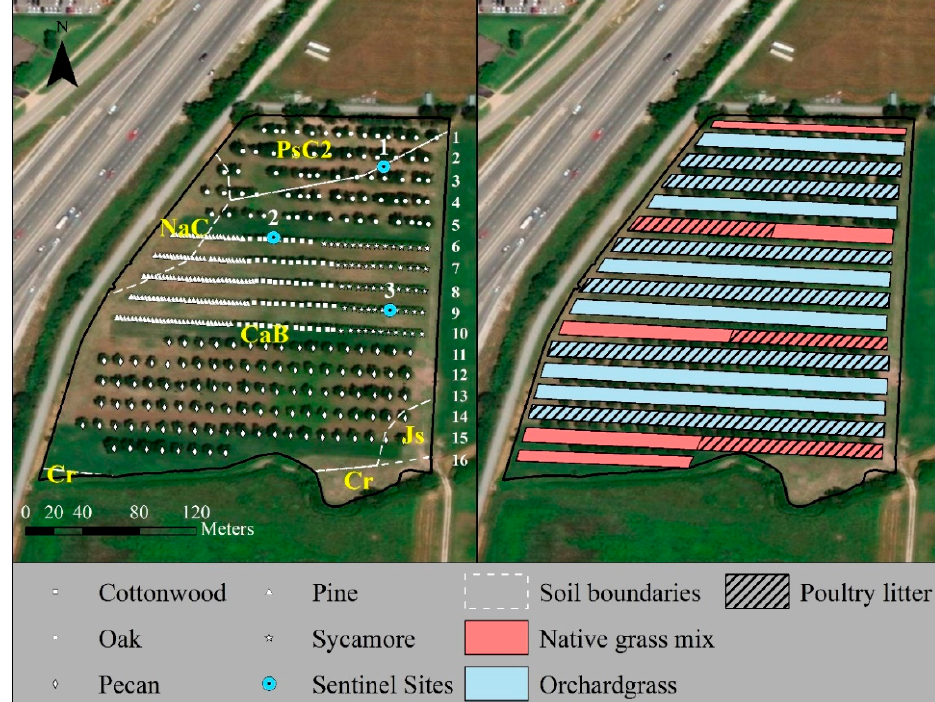
Figure 1. Agroforestry site in Fayetteville, AR is organized into 16 rows, where Row 1 starts at the most-northern row. Rows 1–5 consist of the northern red oak; the western, central, and eastern portion of Rows 6–10 consist of the pitch/loblolly pine, cottonwood, and American Sycamore; and Rows 11–16 consist of pecan. The three sentinel site locations are located at a local summit (Sentinel Site 1), depression area (Sentinel Site 2), and mid-slope area between the summit and depression (Sentinel Site 3). The soils at the site include Captina silt loam (CaB), Pickwick silt loam (PsC2), Nixa cherty silt loam (NaC), Johnsburg silt loam (Js), and Cleora fine sandy loam (Cr; Soil Survey Staff, 2019b). The alleys between the tree rows consist of either orchardgrass or a native grass mix (big bluestem, little bluestem, and Indiangrass), where fertility treatments were fertilized with poultry litter in 2017–2019. Maps were created in ArcGIS (ArcGISmap version 10.6.1, Esri, Redlands, CA,